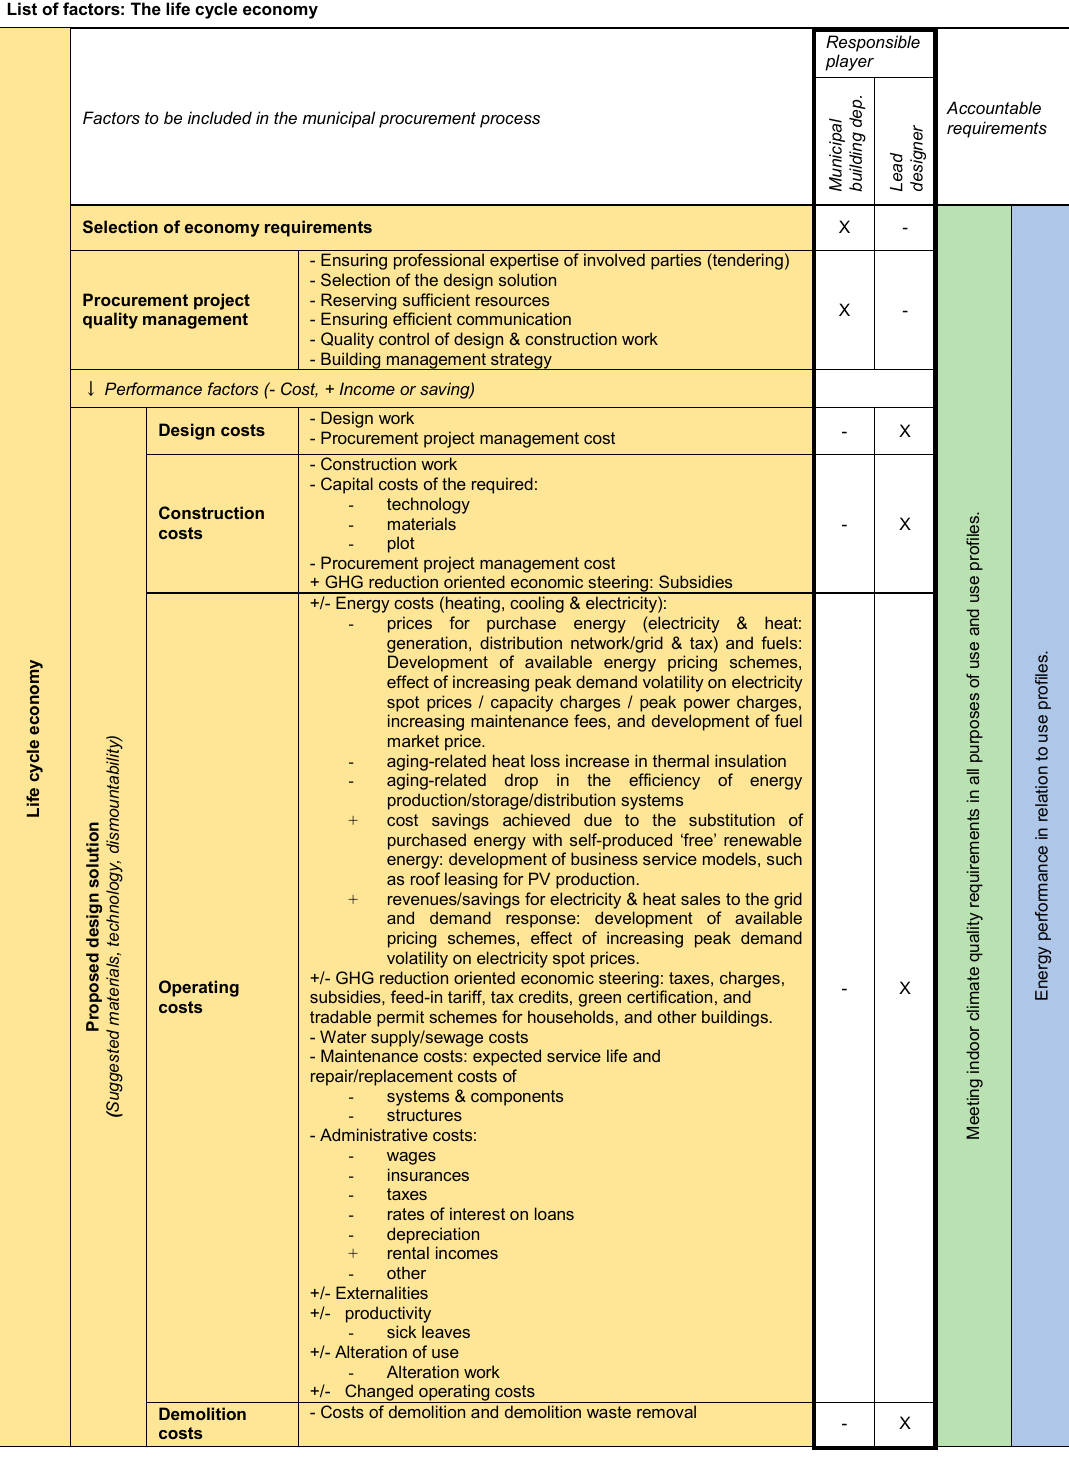
Figure 10. The energy efficiency responsibilities in the design of the municipal building: The life cycle costs of a building. Based on [10,11,14,27,32,36,41,46,47,86,87,92,98]. List of factors: The life cycle economy